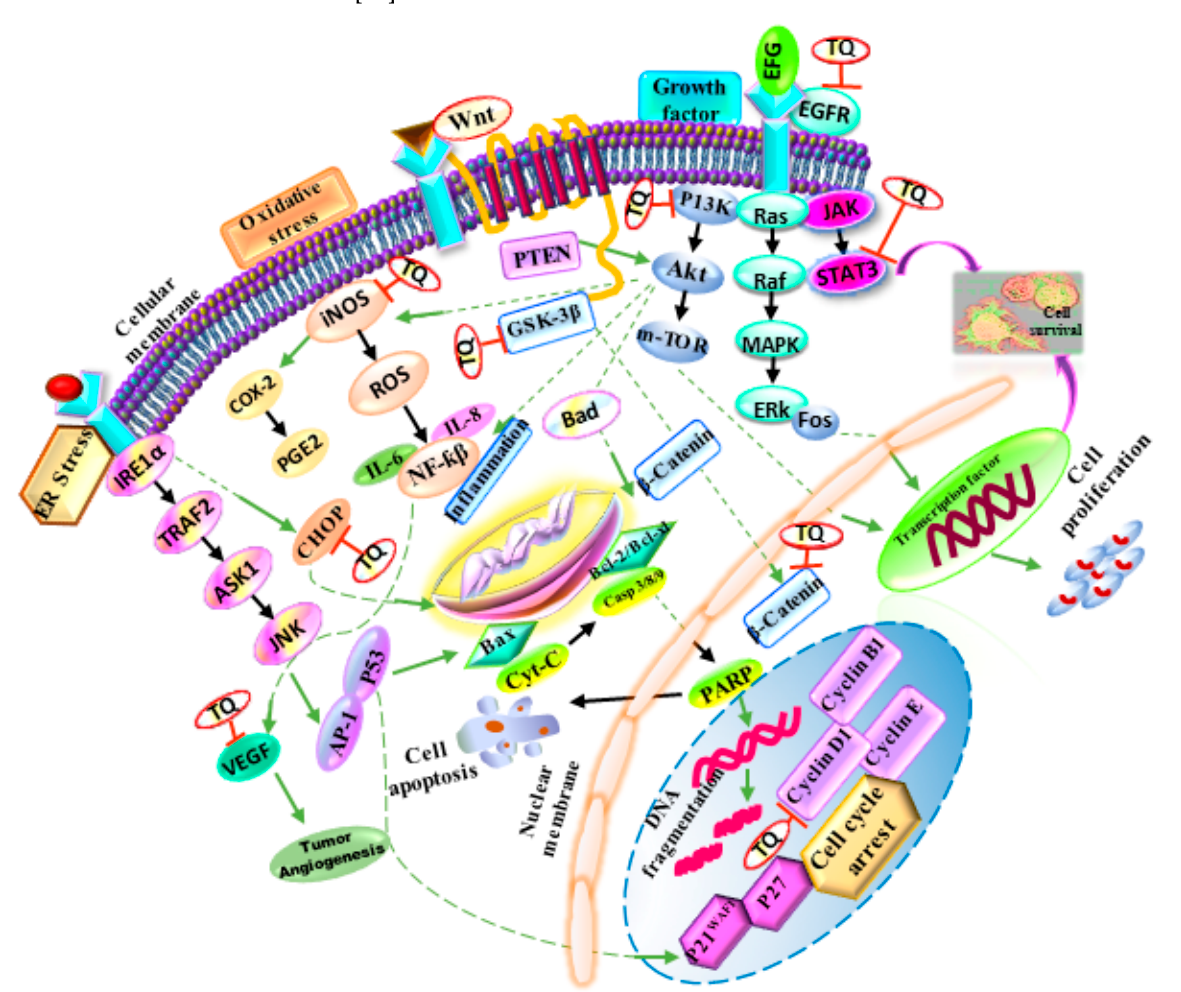
Figure 3. Schematic representation of the anticancer mechanisms of N. sativa and its main components. Thymoquinone (TQ) is able to inhibit cancer development and to regulate various genes involved in survival, proliferation, invasion, angiogenesis, metastasis and apoptosis.